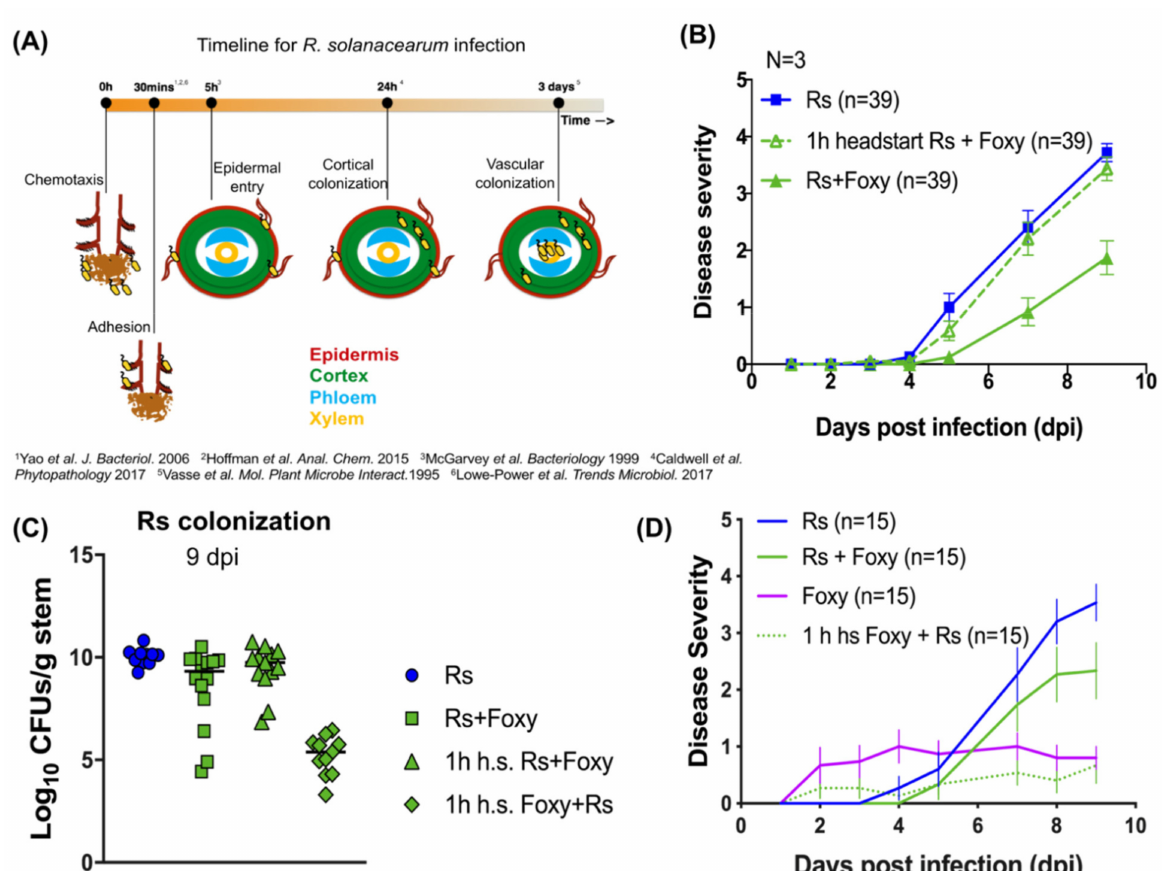
Figure 2. Early interactions determine co-infection outcome. ( A ) timeline for R. solanacearum infection from recognition of the host until colonization of the xylem, gathered from available literature. ( B ) The figure shows disease severity over 9 days for 1 h head-start to R. solanacearum in co-infection (1 h headstart Rs + Foxy) with relevant controls. Two-way repeated-measures ANOVA was performed with time x treatment p < 0.0001. A 1 h head-start to R. solanacearum in co-infection resulted in disease equal to R. solanacearum single infection (1 h headstart Rs+Foxy vs. Rs—Tukey’s p = 0.6131). Simultaneous co-infection resulted in reduced disease (Rs+Foxy vs. 1 h headstart Rs+Foxy—Tukey’s p = 0.0001). ( C ) CFUs of R. solanacearum from shoot tissue 9 dpi; ANOVA p < 0.0001. While co-infection resulted in reduced colonization (Rs vs. Rs+Foxy Tukey’s p = 0.0452), a 1 h head-start to R. solanacearum resulted in similar colonization as found in bacterial